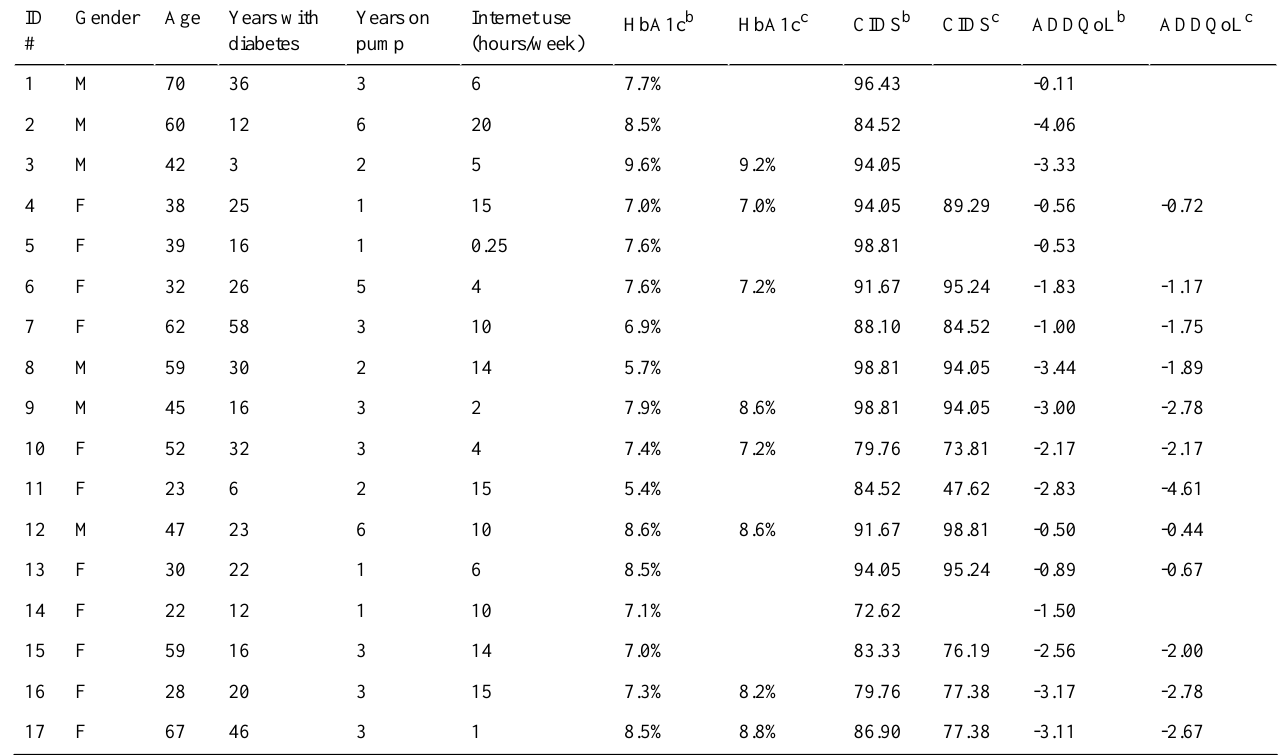
Table 1. Subject characteristics and test results